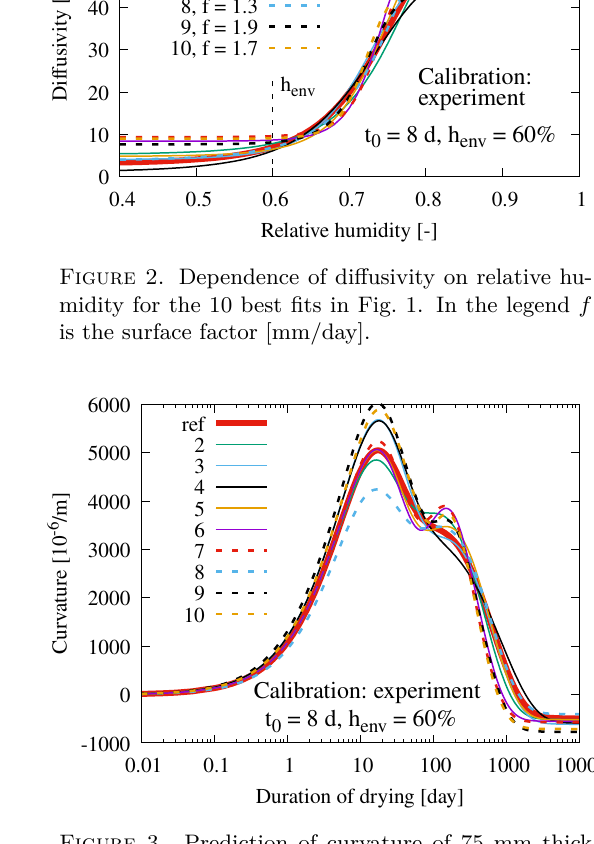
Figure 3. Prediction of curvature of 75 mm thick slab exposed to drying from one side only at h env = 50% which started at the age t 0 = 28 days. The line types and the material parameters correspond to Figs. 1 and